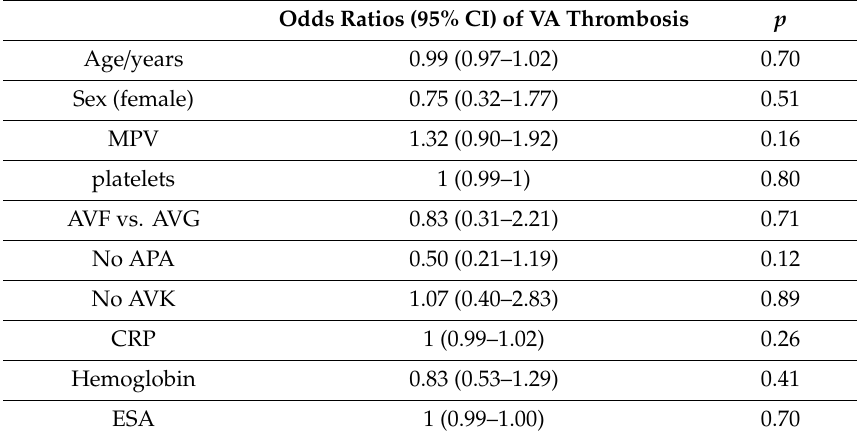
Table 5. Multivariate analysis by cox model of vascular access